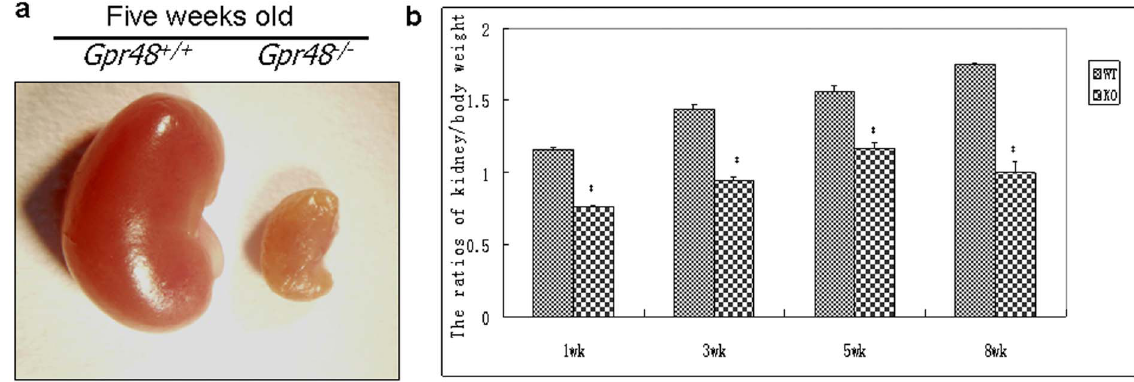
Figure 1. The renal weights and sizes were markedly reduced in the Gpr48 KO mice. (a) The morphology of kidney in five-week old wild- type and knockout mice. Marked polycystic kidney lesions were observed with the naked eyes in the Gpr48 KO mice. (b) The ratios of kidney/body weight in wild-type and knockout mice at different ages.